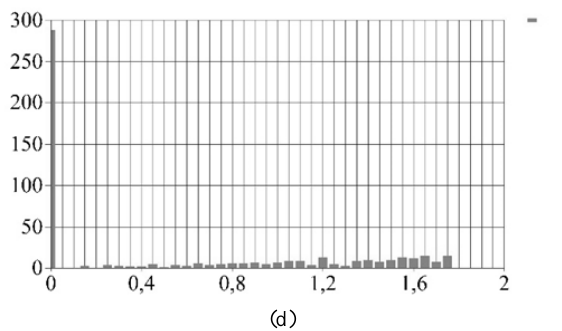
Fig. 4. The results of a fractal analysis of the sea surface section image with an oil spill (image size 1124 × 744; fractal dimension D estimation display field size – 30): (a) - original image; (b) - fractal dimension sheet; (c) - combined image; (d) - histogram of the fractal image